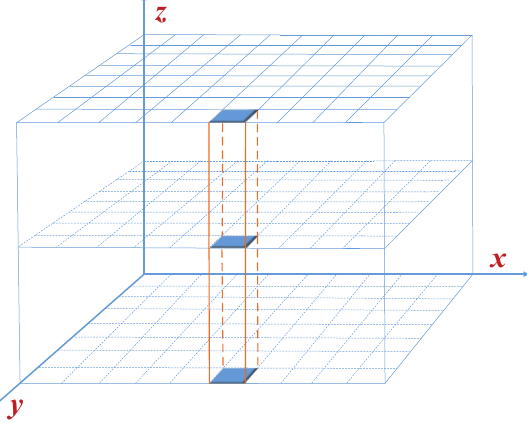
Figure 2. Three-dimensional spatial structure of RRTMG_LW: Its physical dimensions include longitude, latitude, and model